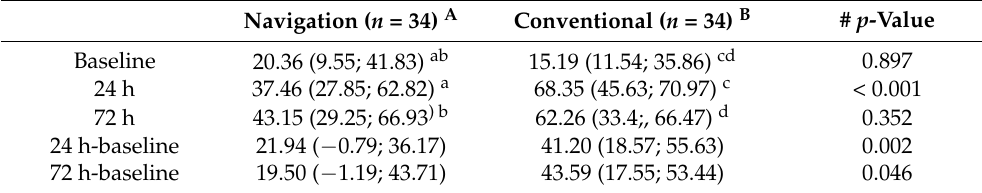
Table 2. Serum soluble P-selectin concentrations (ng/mL) before TKA, then at 24 and 72 h after TKA.